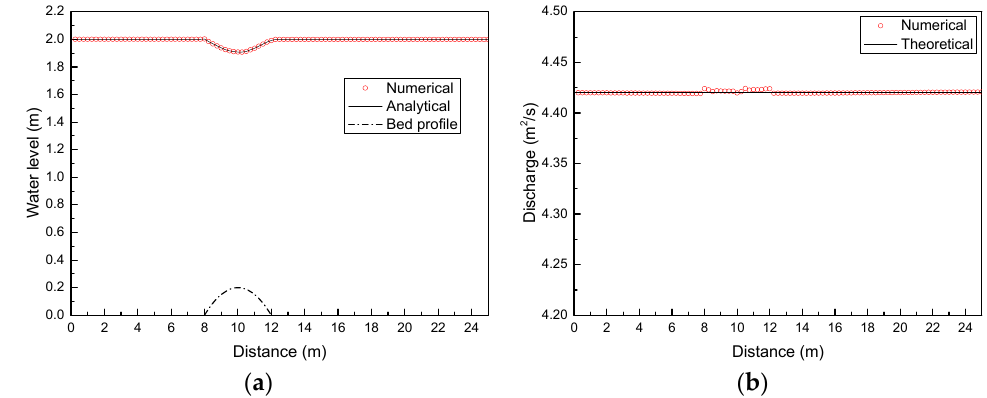
Figure 10. Subcritical flow over a bump: ( a ) comparison of the water level between numerical results and the analytical solution; ( b ) comparison of discharge.